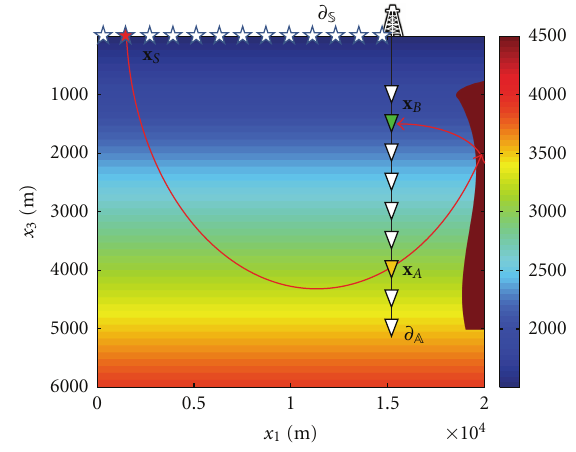
Figure 19: Velocity model for the salt flank imaging example. Sources are located at boundary ∂ S , covering x 1 ∈ [0m,12000m] at x 3 = 0m; receivers are located at boundary ∂ A , covering x 3 ∈ [1000m,5000m] at x 1 = 15000m; a reference virtual source is located at x A =